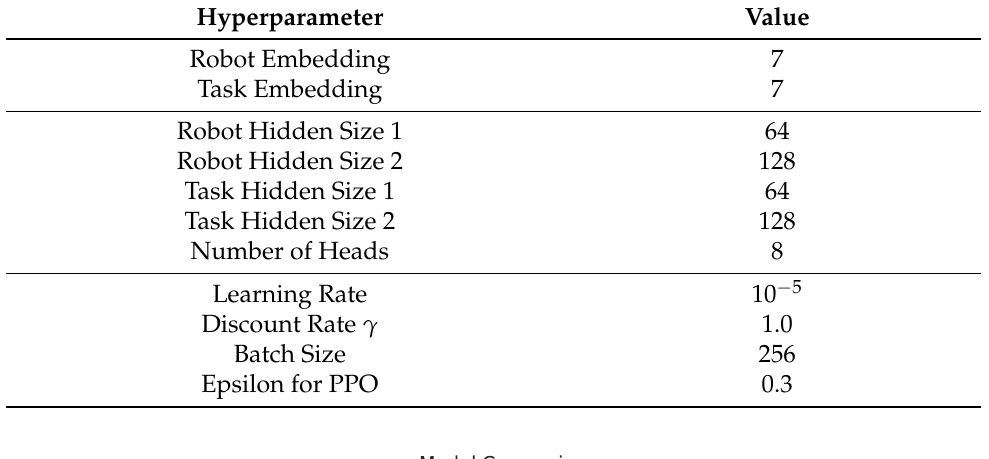
Table A1. Model and training hyperparameters used for experiments.